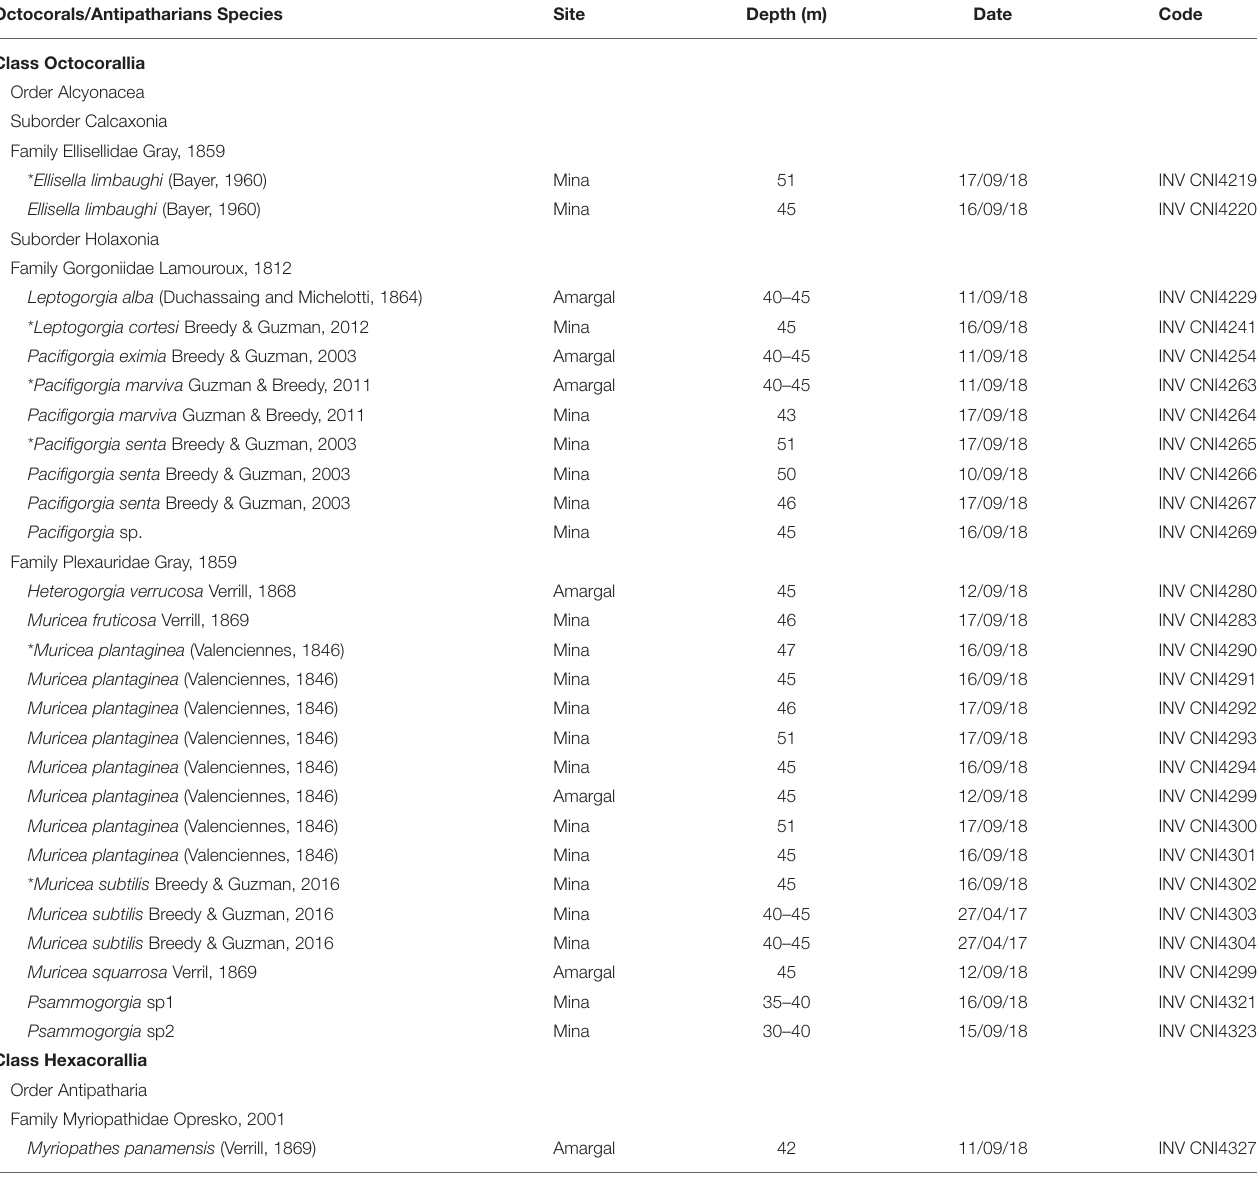
TABLE 1 | Species of mesophotic octocorals and black corals collected in the Chocó, Colombian Pacific. Octocorals/Antipatharians Species Site Depth